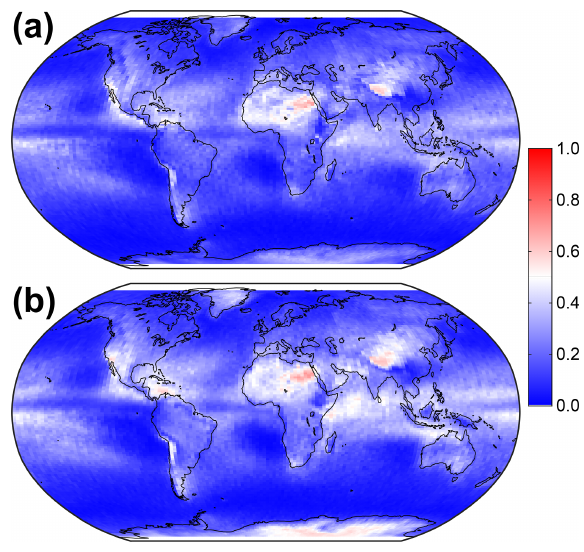
Figure 2. Same as Fig. 1a but separated according to CALIPSO observations during (a) day and (b)